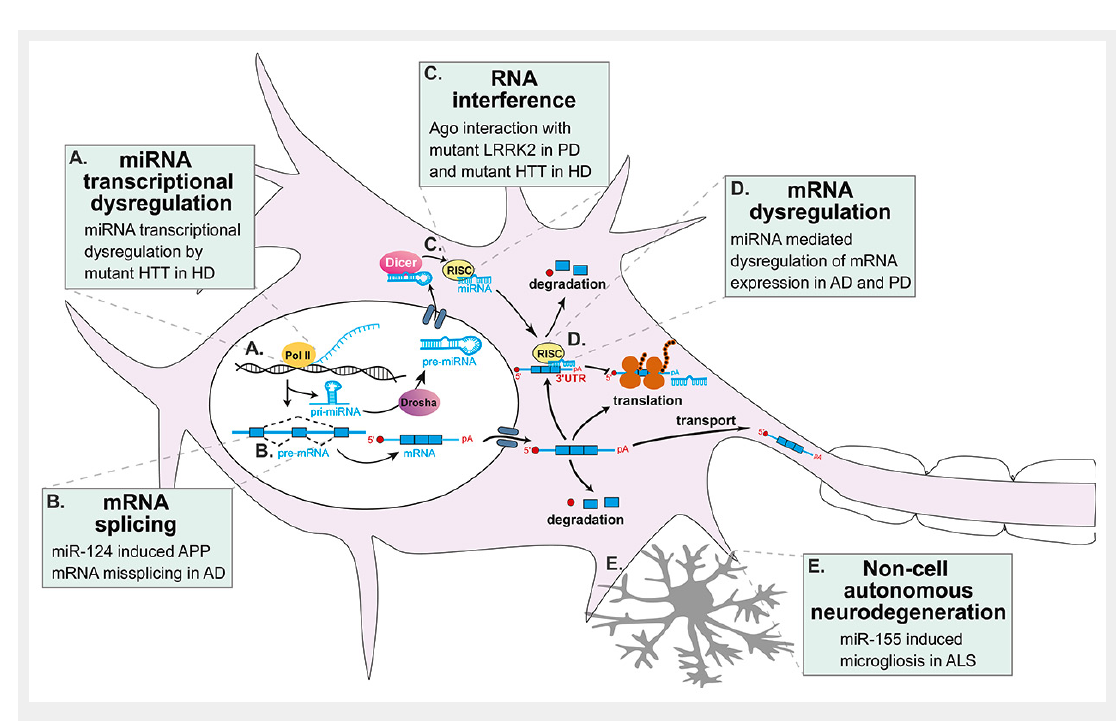
Figure 1: miRNA alternations in neurodegenerative diseases. Numerous alternations in miRNA biogenesis and function were found to contribute to the pathogenesis of several neurodegenerative diseases including: (A) In HD, miRNA transcription is disturbed as mutant huntingtin does not bind REST (which is normally bound to wild-type huntingtin), allowing the formation of NRSE thus repressing the transcription of neuronal miRNAs [135, 181, 183]. Mutant huntingtin also binds to p53 dysregulating p53-mediated transcription of miRNAs [16, 188]. (B) Downregulation of miR-124 has been found to cause missplicing of APP in AD [42]. (C) Ago has been found to be sequestered by mutant huntingtin and accumulated into stress granules in HD suggesting impaired miRNA-mediated mRNA regulation [189–191]. Interestingly, mutant LRRK2 also interacts with Ago, impairing mRNA regulation by miRNAs [72]. (D) Expression of APP and BACE1 in AD [37–41, 48–52] and SNCS and LRRK2 in PD [71-73] has been described to be specifically affected by their regulating miRNA(s) that are disturbed in these diseases. (E) Non-cell autonomous neurodegeneration is now well recognized in ALS and miR-155 seems to play a major role in the pathologic microgliosis [43, 163, 165]. 3’UTR = 3’ untranslated region; AD = Alzheimer’s disease; ALS = amyotrophic lateral sclerosis; APP = amyloid precursor protein; BACE-1 = β- secretase 1; HD = Huntington’s disease; HTT = huntingtin gene; LRRK2= leucine-rich repeat kinase 2; miRNA = microRNA; mRNA = messenger RNA; NRSE = neuron restrictive silencer element; PD = Parkinson’s disease; pri-miRNA = primary miRNA; REST = RE1-silencing transcription factor; RISC = RNA-induced silencing